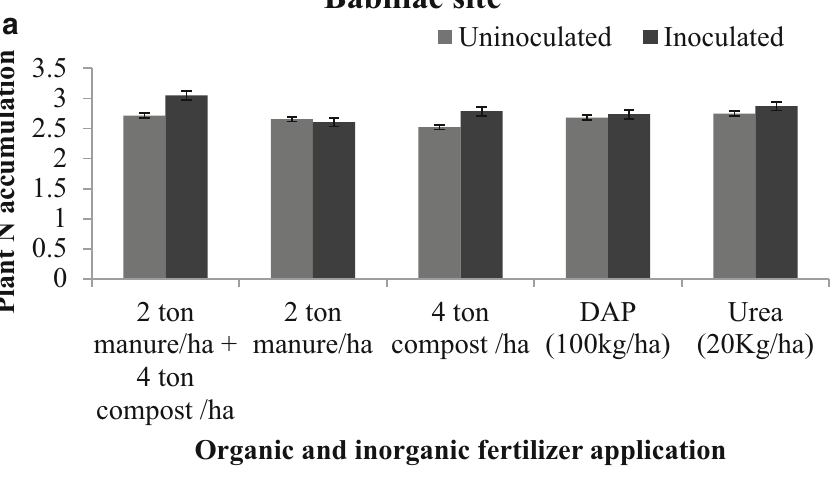
Fig. 4 Effect of Bradyrhizobium inoculation on plant N accumulation of peanut at a Babillae and b Fedis